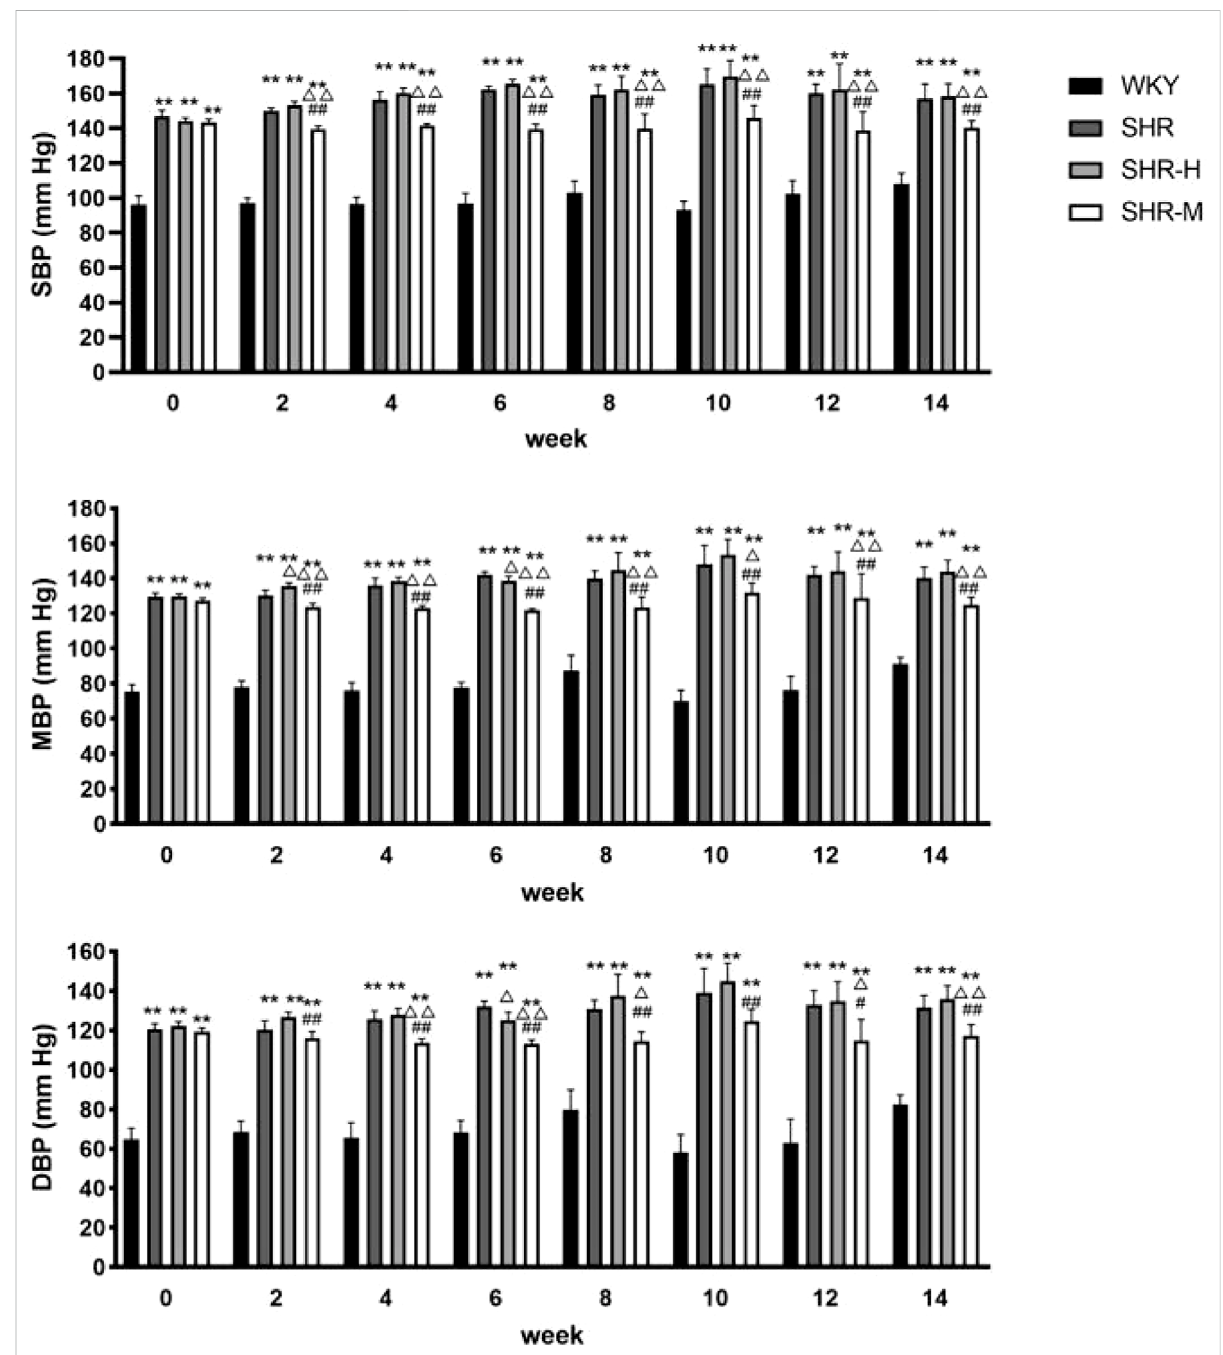
FIGURE 1 Bloodpressurestatisticsfor14consecutiveweeks.EvaluationofMBP,SBP,andDBPatbaseline(week0)andinweeks2,4,6,8,10,12,and14of theprotocol.* p < 0.05and** p < 0.01versustheWKYgroup. △ p < 0.05and △△ p < 0.01versustheSHRgroup. # p < 0.05and ## p < 0.01versustheSHR- H